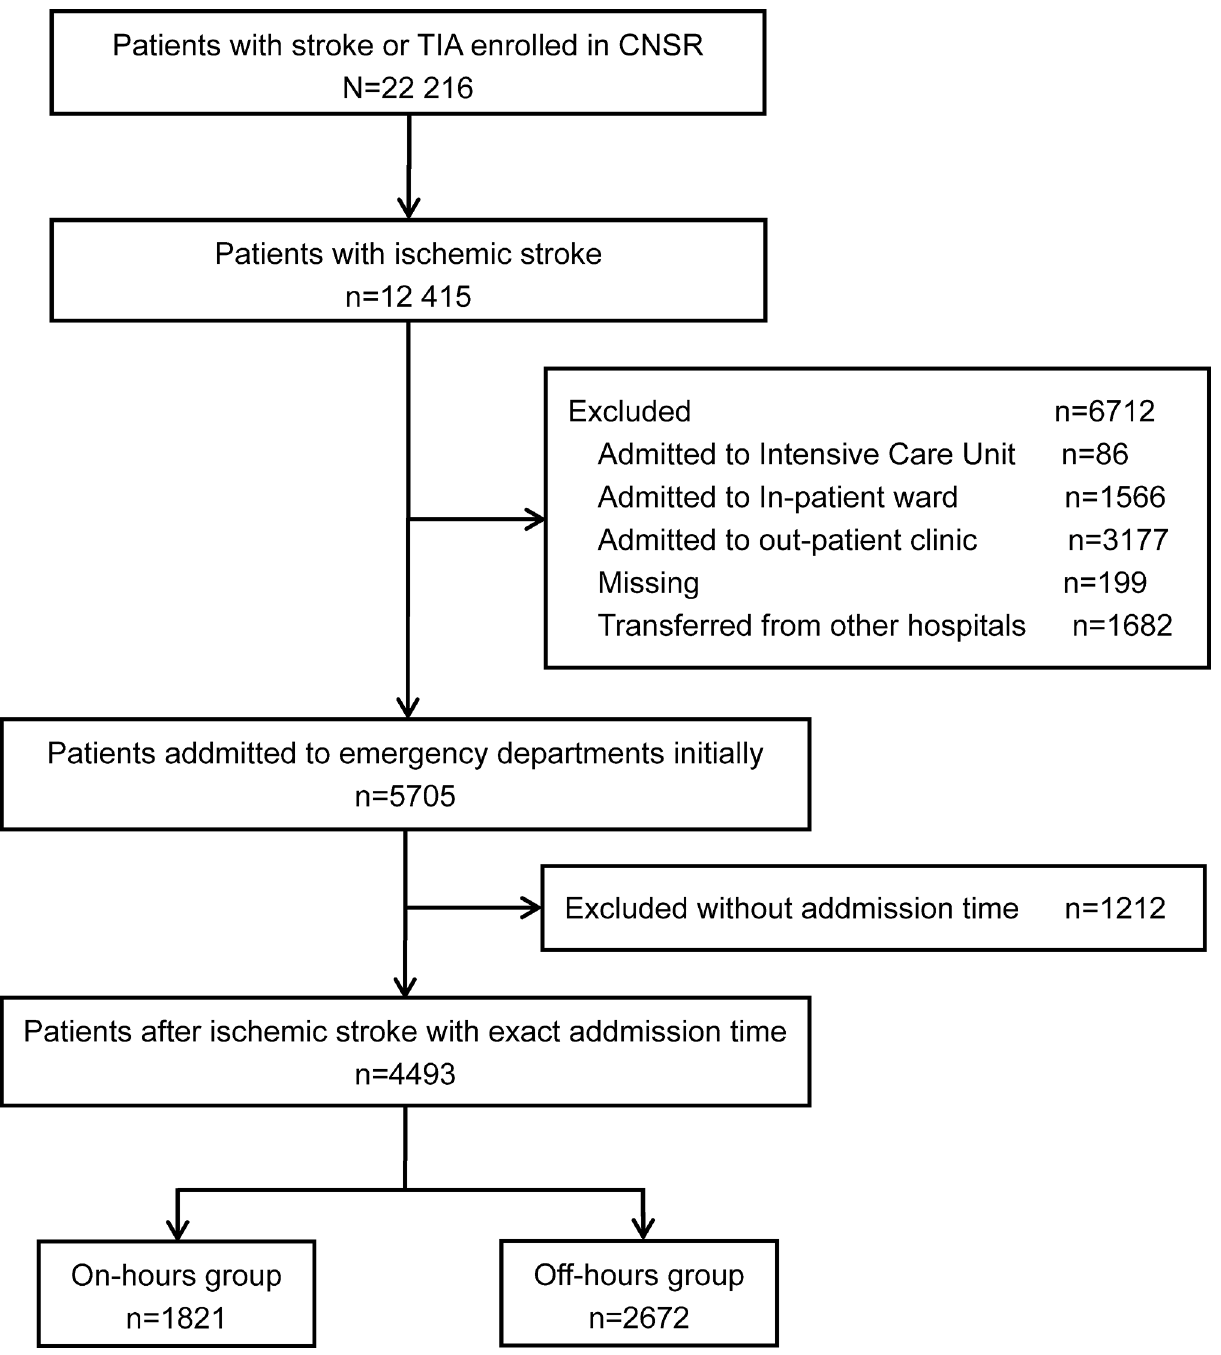
Fig 1. Patient flow diagram. Clinical characteristics of the analyzed population (n = 4493) were compared with patients without exact admission time and excluded from the analyzed patients (n = 1212). No differences in demographic characteristics or risk factor profiles were identified between the two groups, except for the NIHSS score and rtPA within three hours of stroke onset, as shown in S2 Table. Patients with exact admission time had higher NIHSS scores at admission and were more likely to receive rtPA compared with those without admission time.